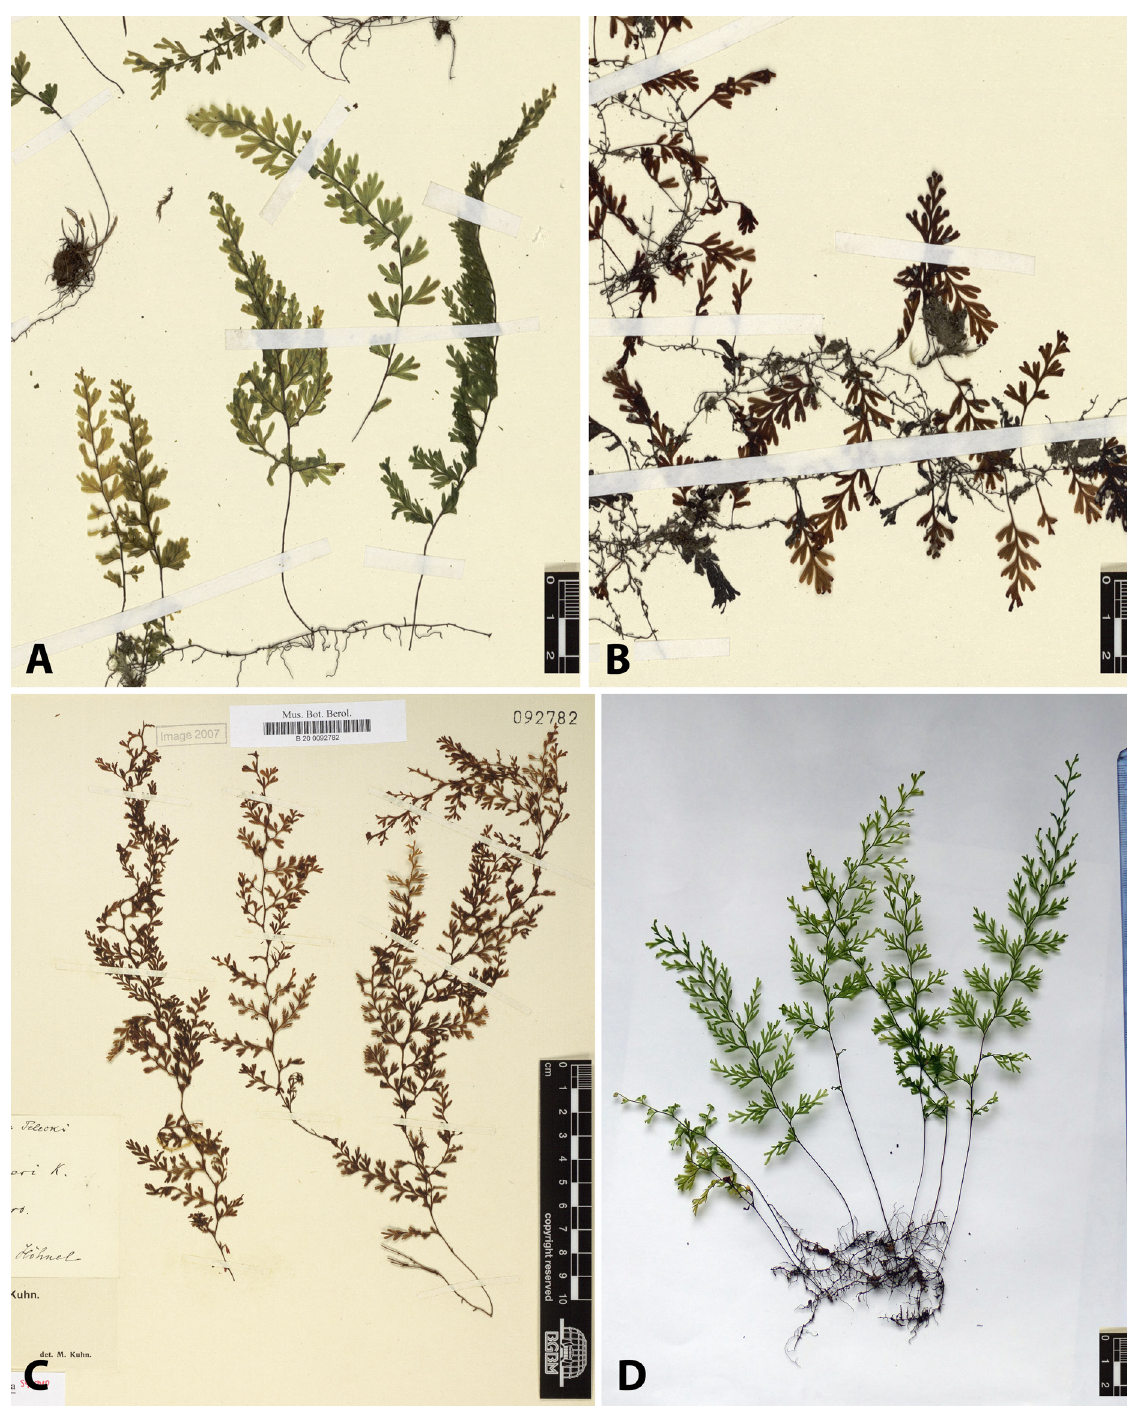
Fig. 5. Western Indian Ocean Hymenophyllum subg. Mecodium , illustrating morphological resemblance of taxa which are difficult to distinguish (see text). A . Hymenophyllum kuhnii C.Chr. from Comoros, firstly identified as H. polyanthos (Sw.) Sw. ( F.Rakotondrainibe et al. 6864 , P00312328). B . Hymenophyllum capense Schrad. from Madagascar, initially identified as H. fumarioides Bory ex Willd. ( F.Rakotondrainibe et al. 6121 , P00212664). C . Syntype of Hymenophyllum kuhnii C.Chr. from Tanzania (B200092782). D . Hymenophyllum inaequale (Poir.) Desv., representative specimen from La Réunion ( L.Bauret 190 ,